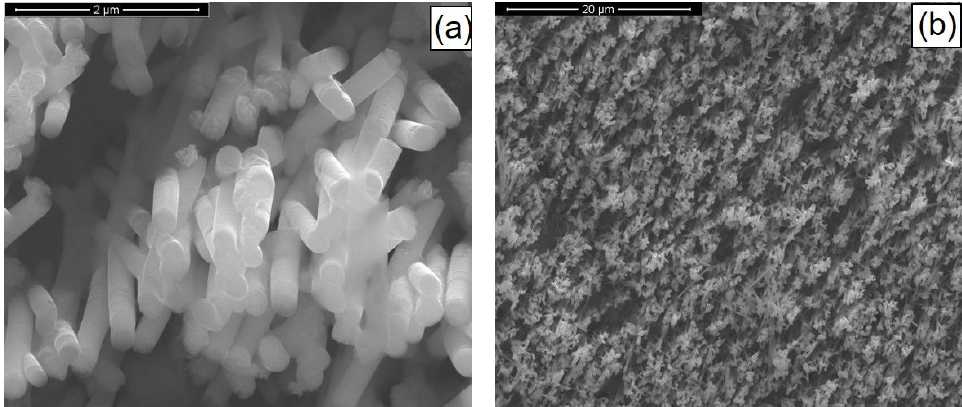
Figure 11. SEM images at high ( a ) and low ( b ) magnifications of CIGS-based nanostructures. NWs were obtained at pH = 2.7 with a gallium content of 57 mM and at 1.53 mA/cm 2 .